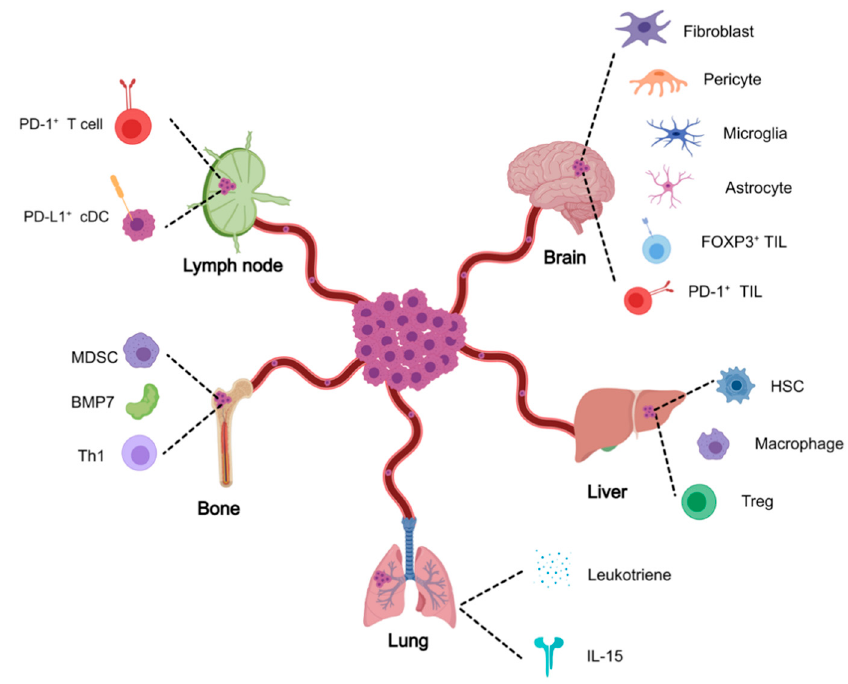
Figure 3. Colonization of DTCs in different organs . Disseminating cells selectively colonize in different tissues and commence the process of further dissemination. The expansion to a metastatic colony relies on the ability to initiate organ-specific colonization programs that allow the tumor cells to survive in a new microenvironment. Colonization is dependent upon a combination of tumor cell and tissue-specific factors. Description of organ-specific metastatic programs is described in the text.